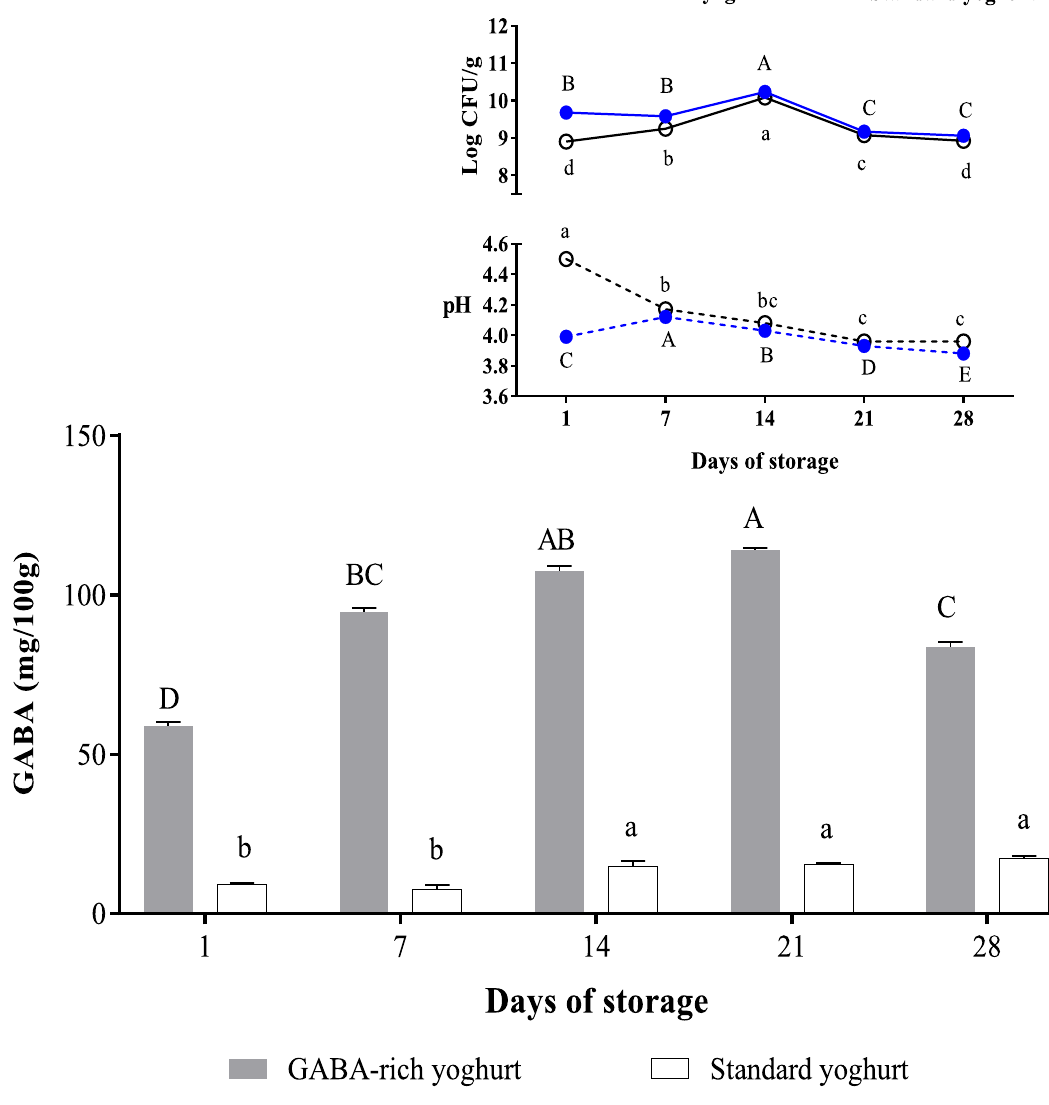
Figure 3. GABA content, viable cell count and pH of GABA-rich yoghurt compared to standard yoghurt during 28 days of storage at 4 °C. Different letters indicate significant difference ( p < 0.05) among GABA-rich yoghurt (capital letters) and standard yoghurt (small letters) on different days of